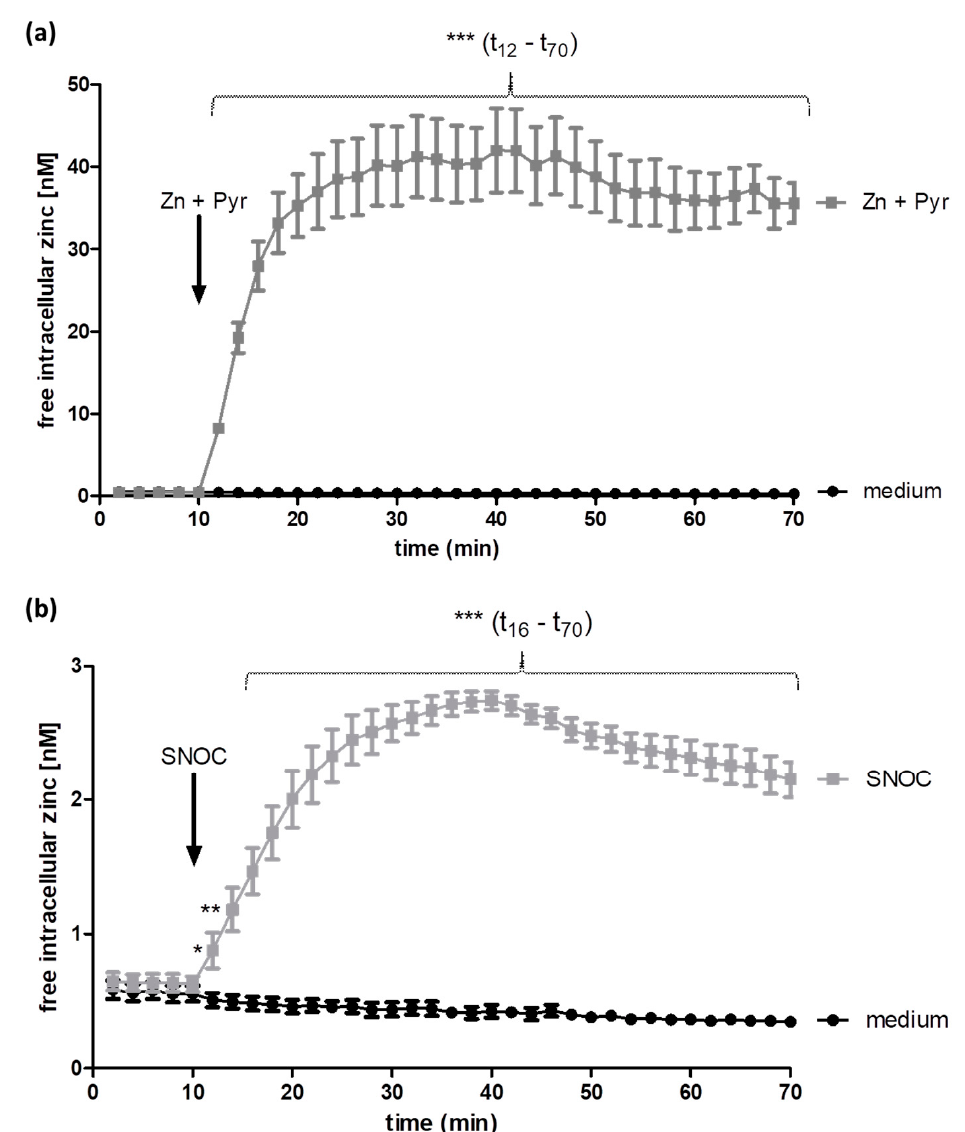
Figure 1. Increase of intracellular free zinc levels. Incubation with zinc (Zn, 50 µM) and pyrithione (Pyr, 0.5 µM) ( a ) or SNOC (2 mM) ( b ) induces an increase of the free intracellular zinc concentration. After assessing a base line, the kinetic measurement was started immediately after adding zinc and pyrithione or SNOC (arrow) and was conducted by using a well plate reader. Data of n = 6–7 independent experiments are shown as means +/ − SEM. Statistical significances, calculated by students t -test, are depicted as * ( p < 0.05), ** ( p < 0.01) or *** ( p < 0.001). Braces show significant elevated zinc levels (***) for all included time points.